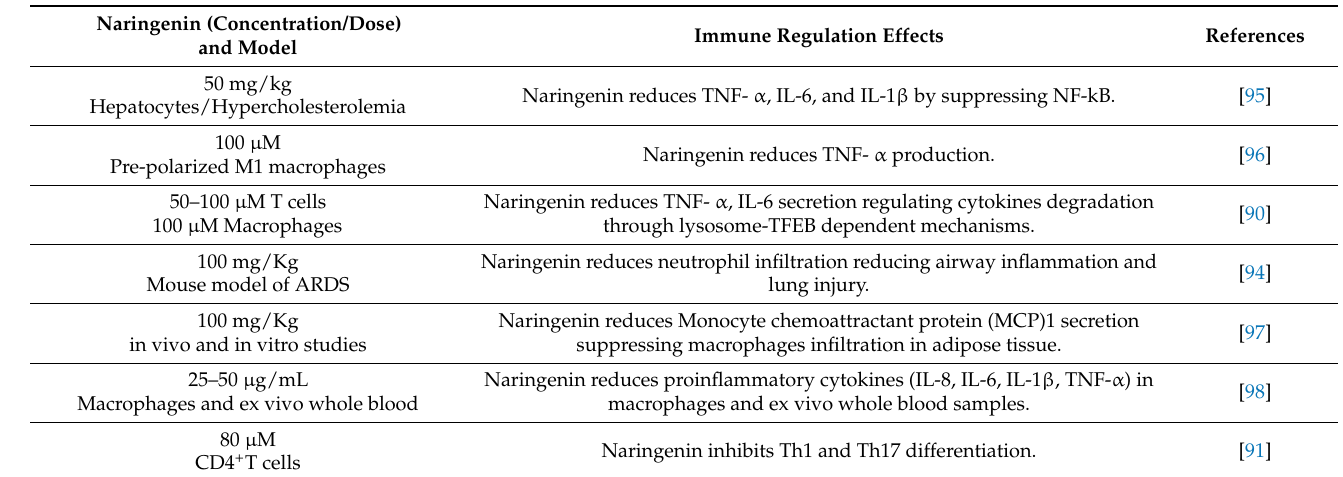
Table 1. Notable regulatory effects of naringenin on the immune